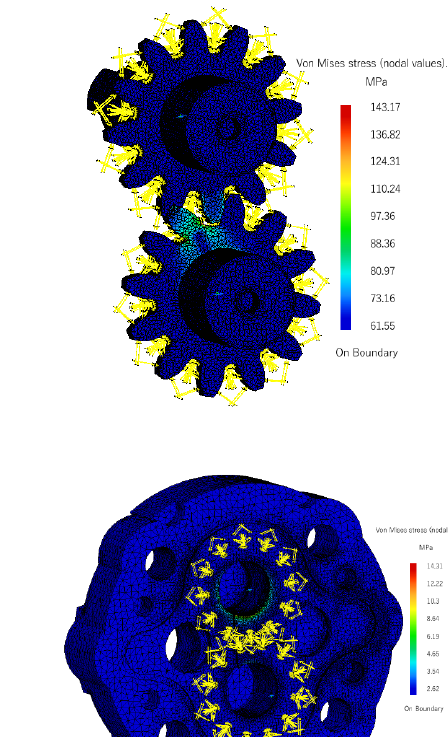
Figure 11. Stress evolution in the body, cover and compensator, depending on applied F d forces .